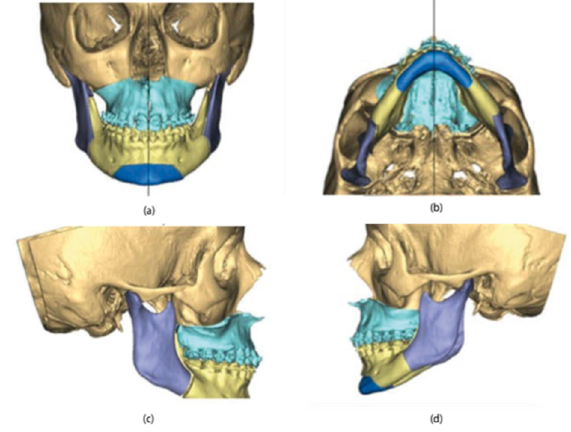
Figure 3. 3D maxillary and mandibular models in the final position: ( a ) front view; ( b ) bottom view; ( c ) right-side view; ( d ) left-side view.